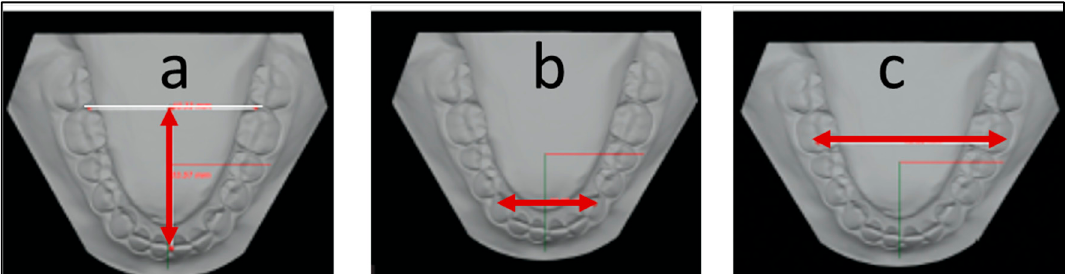
Figure 2. Measurement of maxilla and mandibular arch sizes. ( a ) arch length, ( b ) intercanine width, and ( c ) intermolar widths.